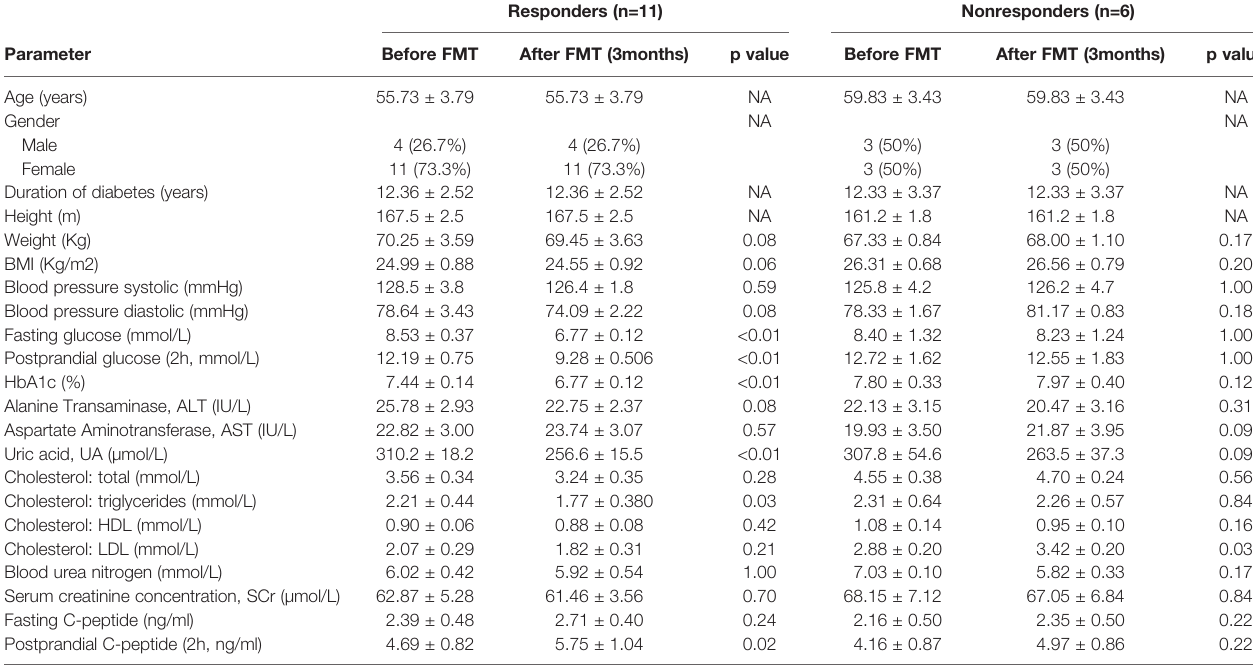
TABLE 2 | Changes in the study parameters before and after FMT treatment in responders and nonresponders.